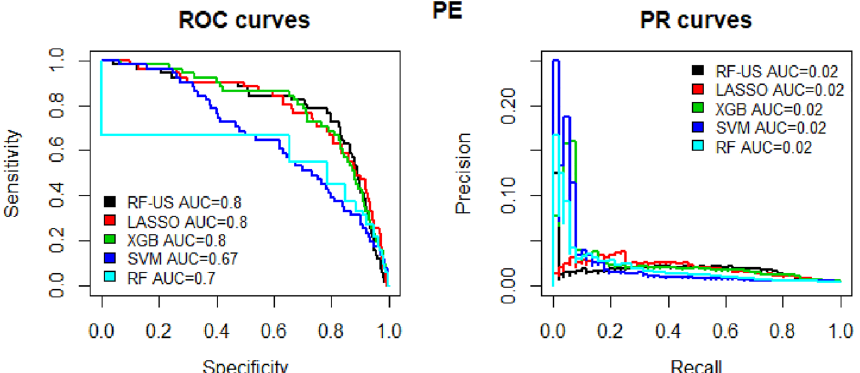
Figure 1. ROC curves for the various models that were assessed for PE.